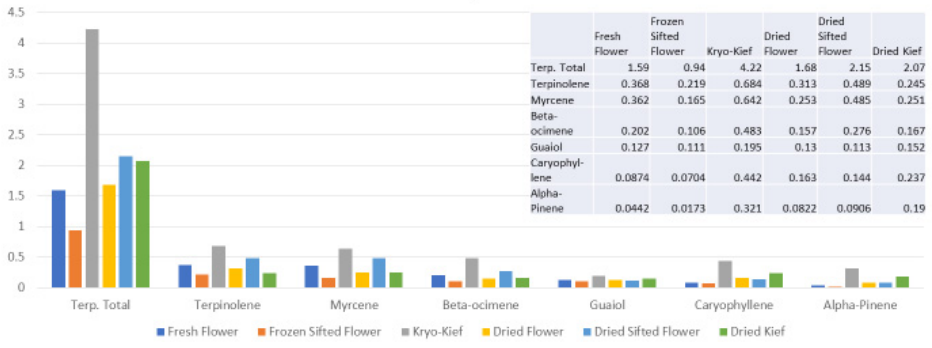
Figure 5. Astral Works Type II chemovar terpenoid assay results (all figures are %).